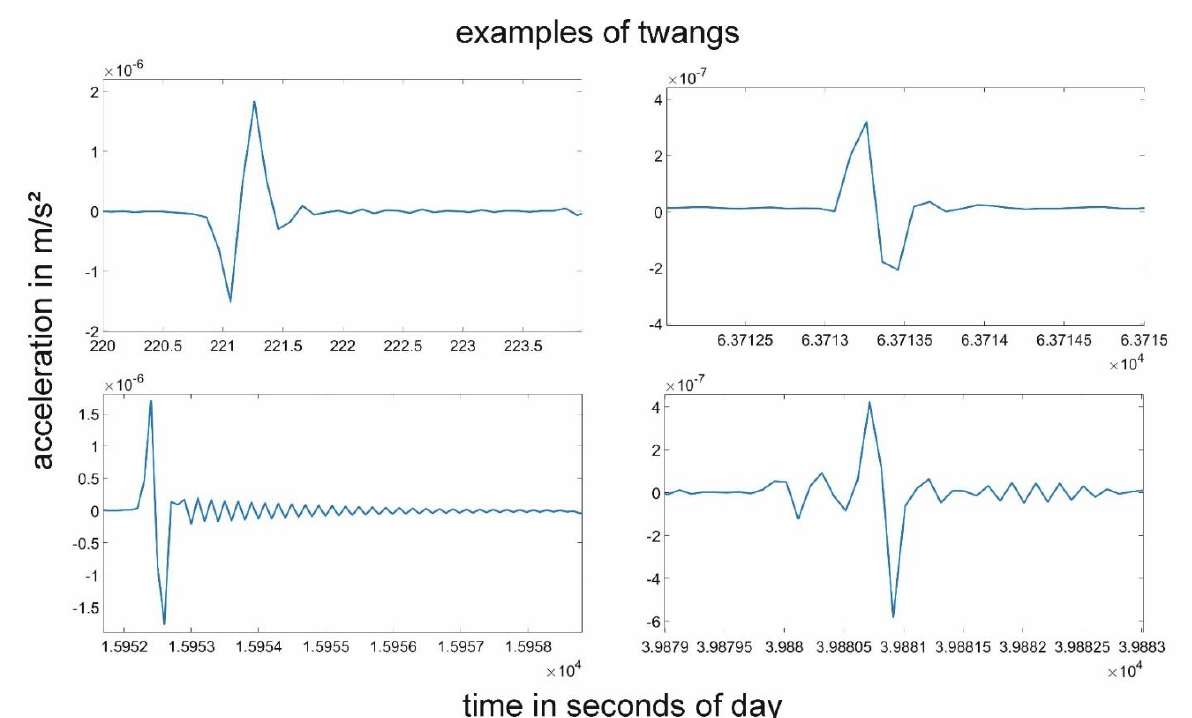
Figure 14. Twangs have varying shapes. In most cases, they consist of double or triple peaks, but more peaks can also occur. An oscillation following the peaks is as common as a precursor peak or even precursor oscillation. These examples are taken from GRACE B on 25 April 2003. The two twangs on top show the two distinct parts of a twang, the high amplitude oscillation with a rapid decay and the following low amplitude oscillation with slow decay.